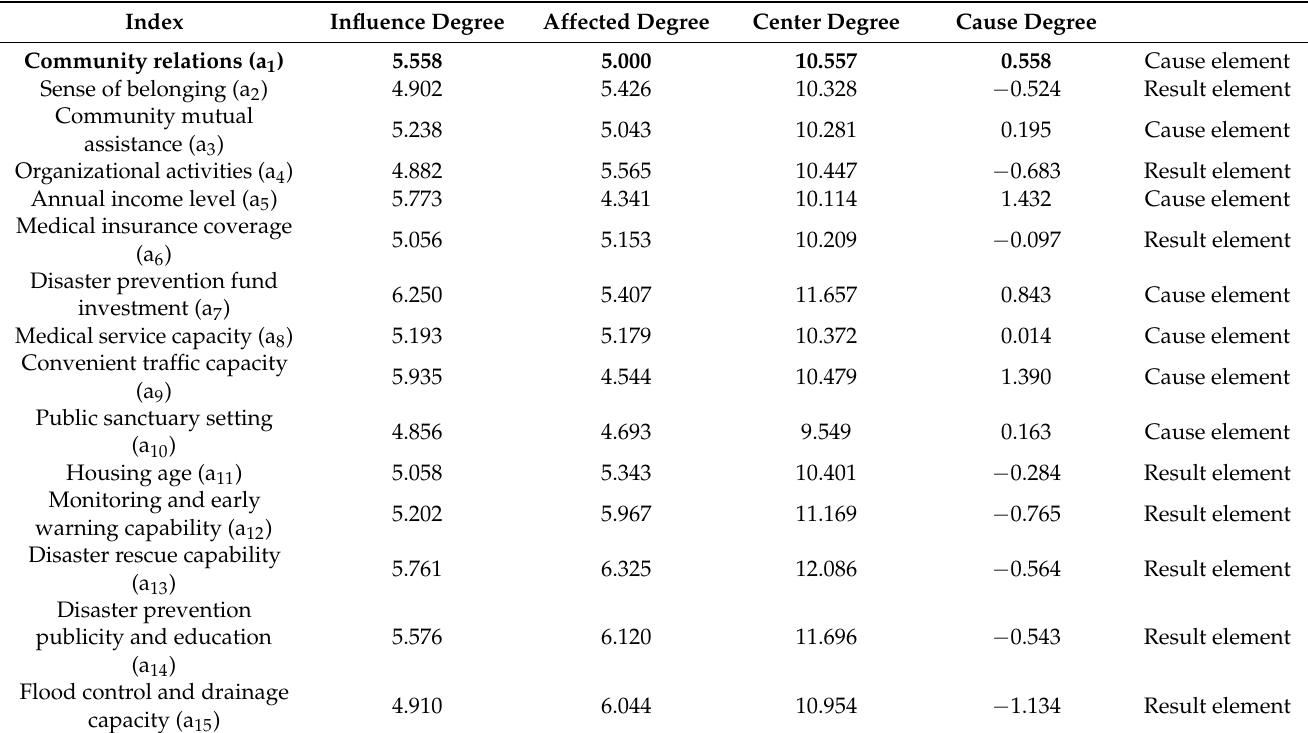
Table 4. Cause–result elements.